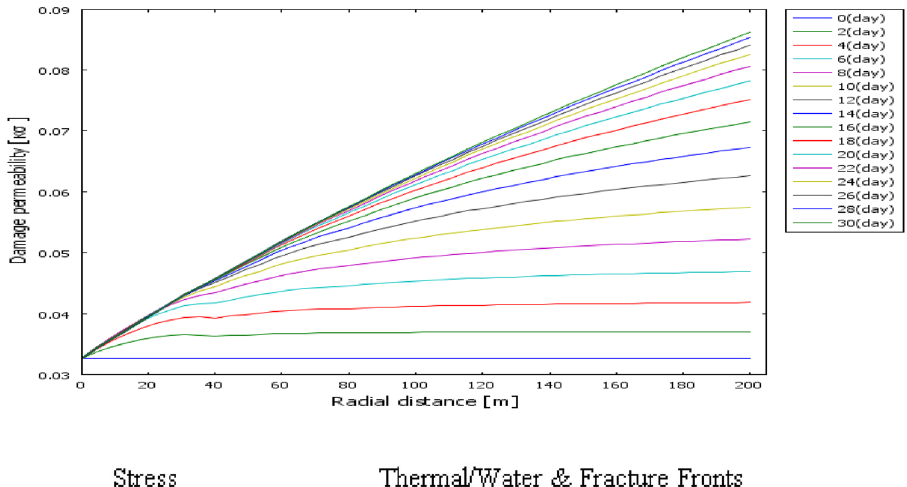
Fig. 12 Field Studied case fracture height versus time